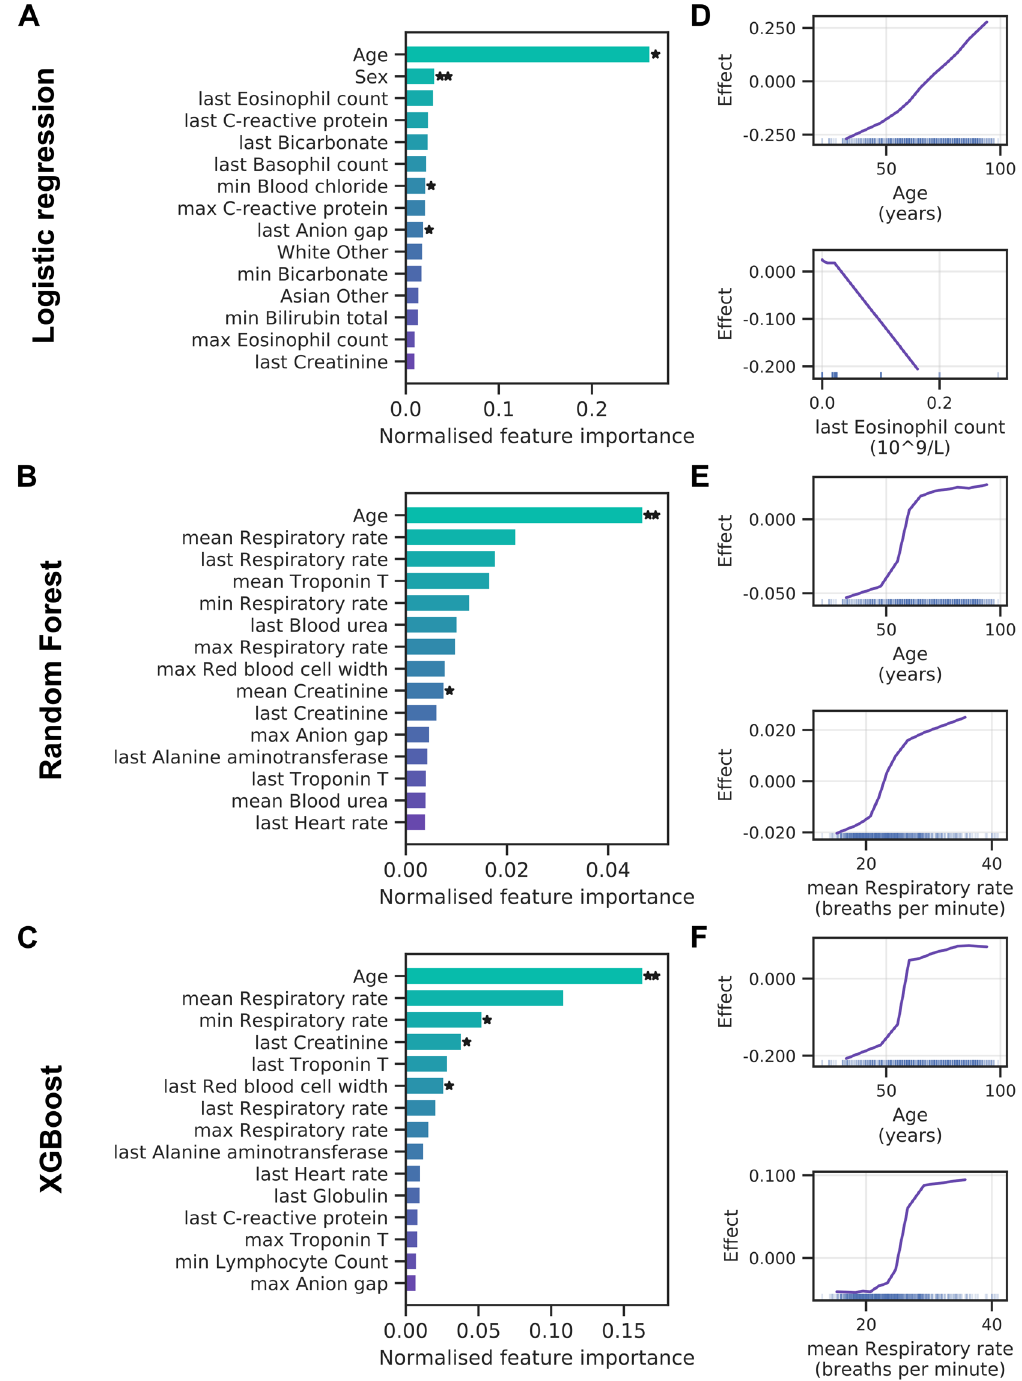
Figure 7. Feature importance for mortality. ( A–C ) Permutation feature importance for the logistic regression ( A ), random forest ( B ) and XGBoost ( C ) models. Only the top 15 features are shown. Asterisks mark features with importance scores significantly different from zero across three cross-validation folds with t-test p value thresholds of 5% ( *) and 1% (* *). ( D–F ) Accumulated local effects plots for the logistic regression ( D ), random forest ( E ) and XGBoost models ( F ). The top two features according to permutation feature importance are shown for each model. Vertical bars at the bottom indicate feature values observed in the data